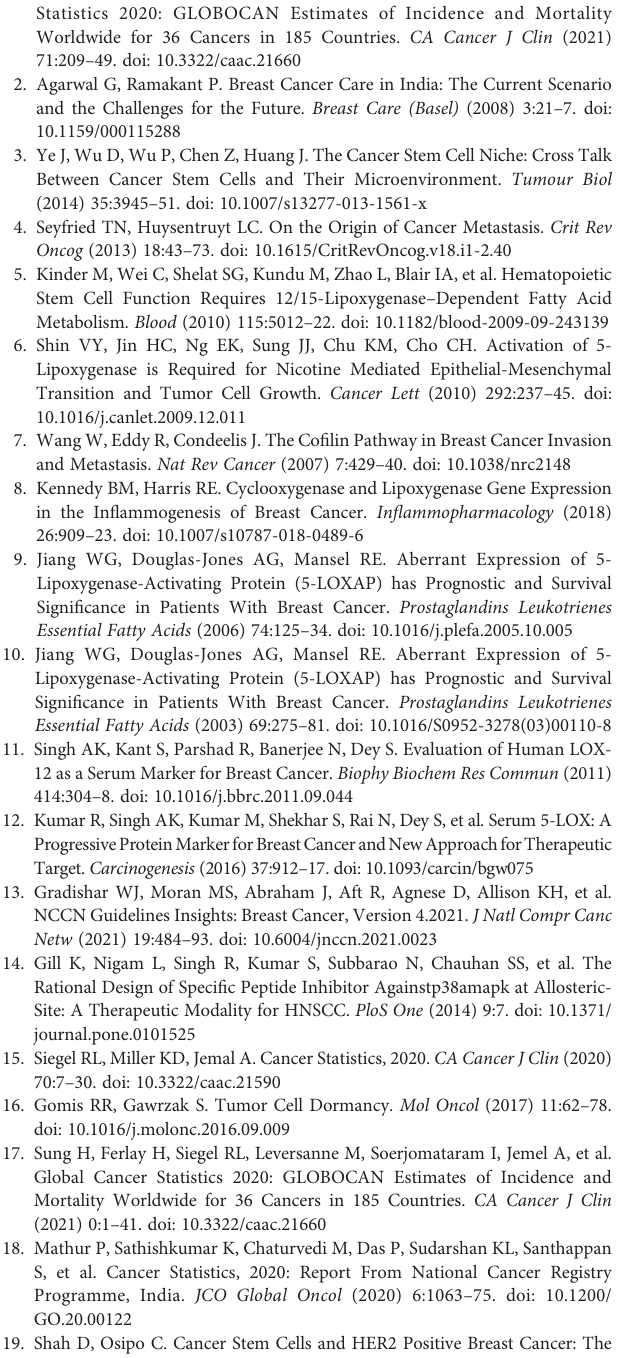
Supplementary Figure 2 | Standard curve of LOX5, Rac1, Rac1b, p38 a , phospho-p38 a (Y-182), LIMK1, phospho-LIMK1 (T-508), co fi lin1, and phospho- co fi lin1 (S-3)